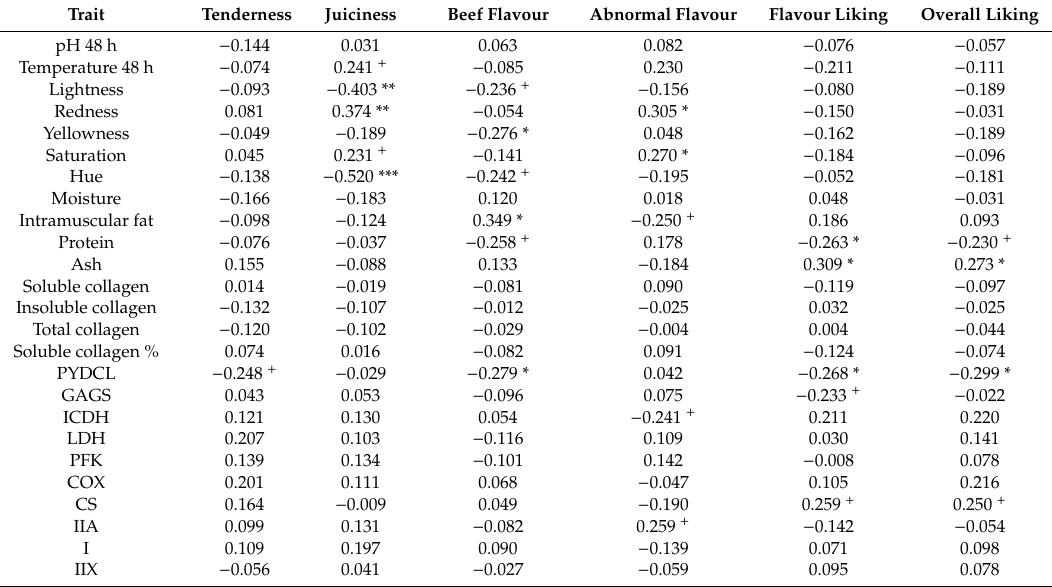
Table 7. Partial correlations (r) between longissimus muscle biochemical and sensory traits 1 . Trait Tenderness Juiciness Beef Flavour Abnormal Flavour Flavour Liking Overall